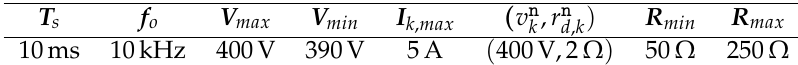
Table 2. DC MG parameters simulated with